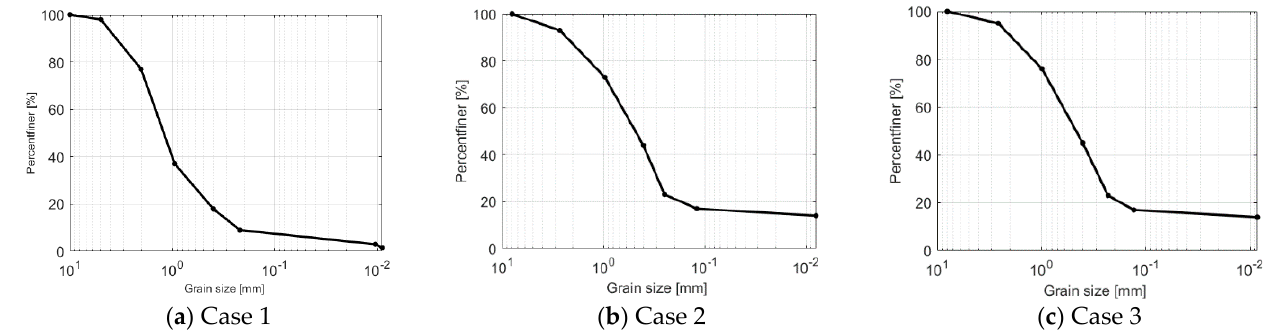
Figure 2. Particle size distribution curves for each experimental condition.